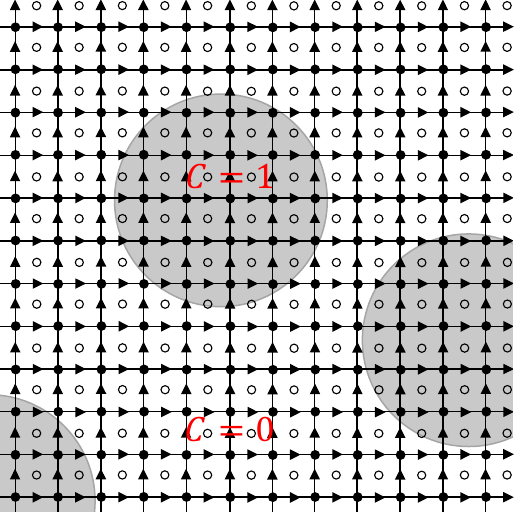
Figure 1. Projected phase function C on staggered grids. Pressure in black circles, the velocities as arrows and viscosity in white circles